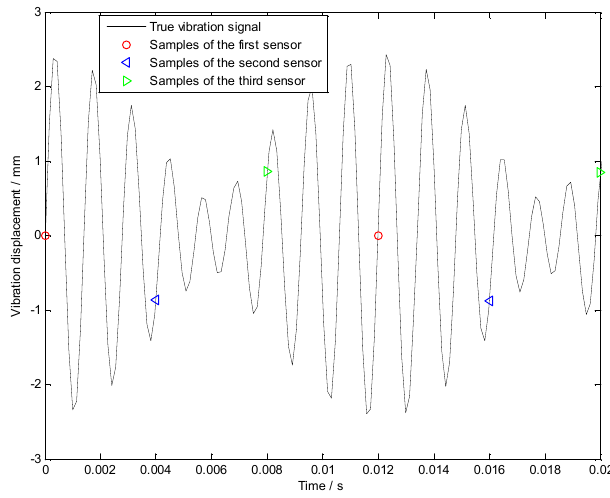
Figure 5. Uniformly sampled signals of three BTT sensors.